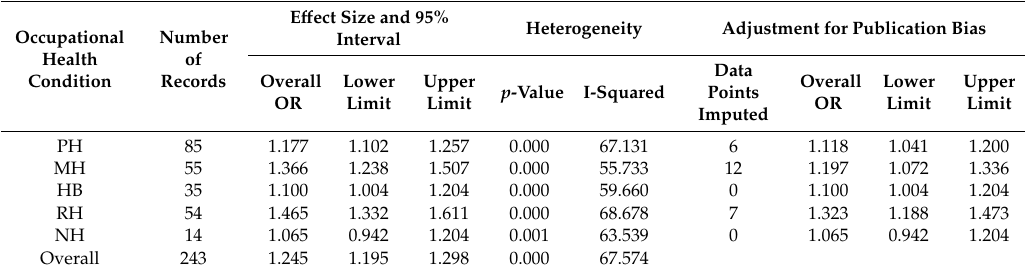
Table 2. Results of meta-analysis between long working hours and occupational health conditions and the adjustment for publication bias.